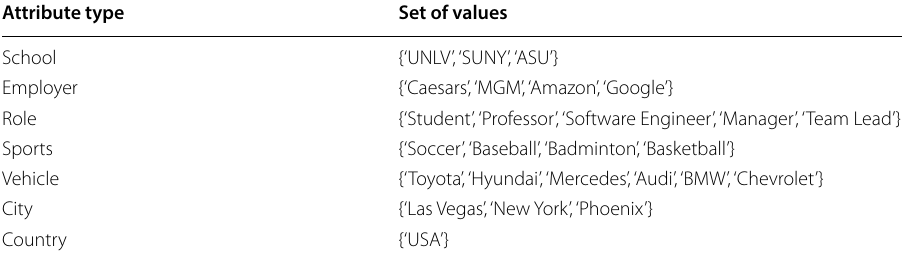
Table 2 Node attributes of sample graph in Fig. 2a